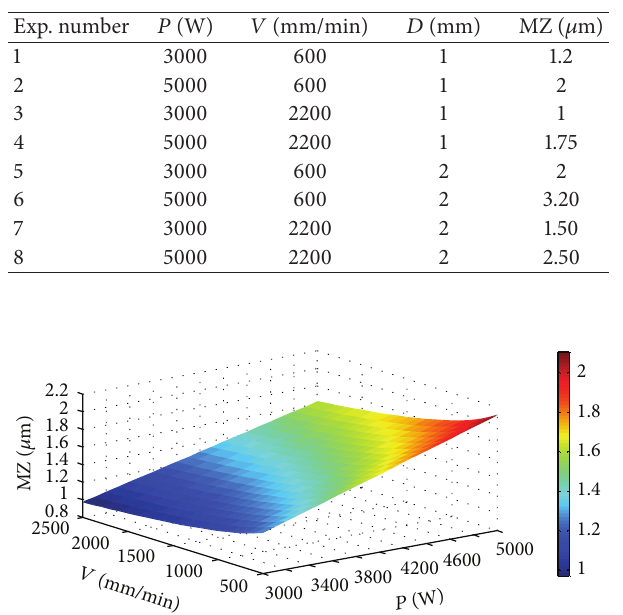
Table 6: Design matrix and experimentally measured response (MZ).